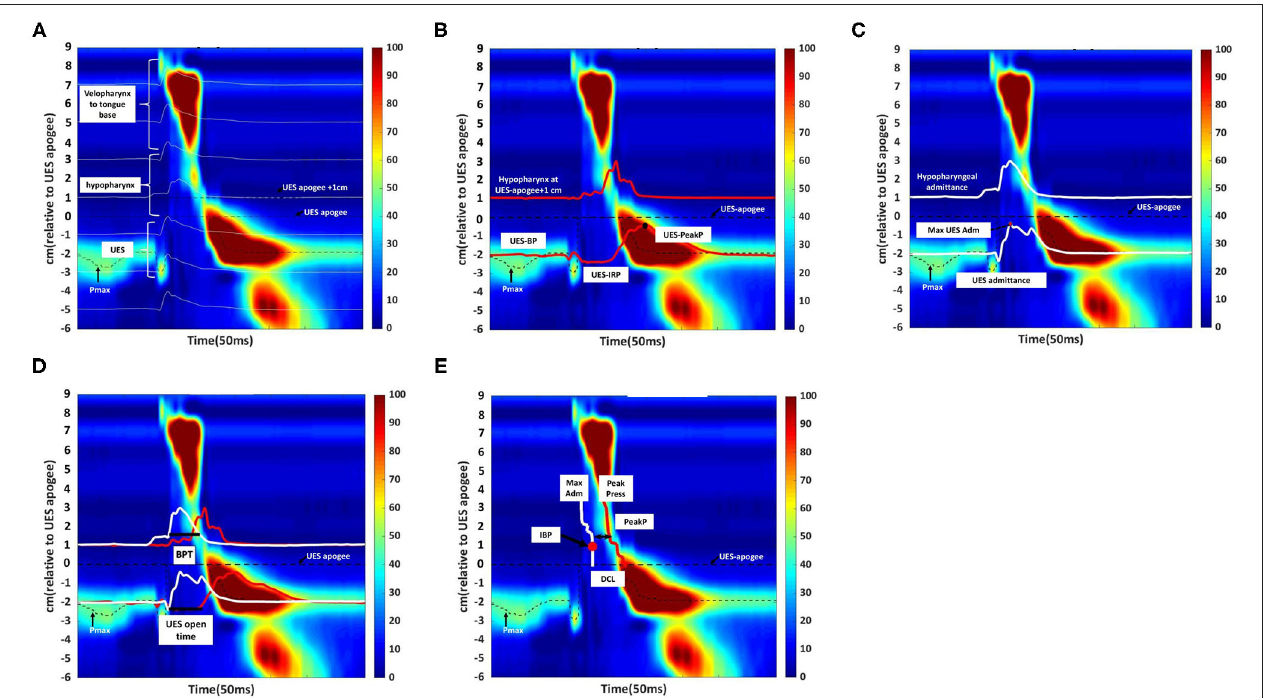
FIGURE 3 | Swallowing function assessment via High -Resolution Impedance Manometry (HRIM). (A) Illustrative example of our data from the pressure sensors on the HRIM catheter (y-axis) over time (x-axis). The graph shows the oropharyngeal pressure topography, from the velopharynx to the tongue base, hypopharynx, and into the upper esophageal sphincter (UES). The high-pressure zone is the UES. The impedance channels from the velopharynx into the esophagus are indicated by white horizontal lines. Effective oropharyngeal muscle contraction relies on bolus transmission, during which the impedance level decreases. (B) Illustrative example of measurement of the parameters of hypopharyngeal and upper esophageal sphincter (UES) pressures. The upper red line represents the pressure waveform recorded at the hypopharynx during the swallow (apogee + 1cm). The lower red line represents the UES pressure waveform, constructed from pressures recorded at the maximum UES pressure position over time. The mean pre-deglutitive UES basal pressure (UES-BP), UES integrated relaxation pressure (UES-IRP), and post-deglutitive UES peak pressure (UES-PeakP) can be identified at the lower red lines. (C) Illustrative example of measurement of the parameters of hypopharyngeal and upper esophageal sphincter admittance. Admittance (S) is the inverse product of impedance ( Ω ), i.e., S = 1/ Ω . Admittance increases with bolus distension of the hypopharynx and UES. The maximum admittance within the UES (Max UES Adm) is represented by the maximum cross-sectional area of the lumen. The lower white line represents the UES admittance waveform, which is constructed from impedance recorded at the Pmax position over the swallowing period. The upper white line represents the admittance waveform at the hypopharyngeal position during the swallow (apogee + 1cm). (D) Illustrative example of measurement of bolus presence time (BPT) and upper esophageal sphincter (UES) open time. The lower section of the graph represents the UES region. The red line represents the UES pressure waveform, which is constructed from pressures recorded at the Pmax position over time. The white line represents the admittance waveform. UES open time was calculated from UES admittance and the pressure waveform, which were used together to define the onset of UES opening (based on the admittance upstroke in the UES), and UES closure (based on the pressure upstroke in the UES). The upper section of the graph represents the hypopharynx region (apogee + 1cm). The red line represents the hypopharyngeal pressure waveform, and the white line represents the admittance waveform. The UES admittance level at the time of closure was used as the threshold to commence the hypopharyngeal admittance recording. The period when hypopharyngeal admittance exceeded this threshold was defined as the bolus presence time (BPT). (E) Illustrative example of measurement of the hypopharyngeal parameters. The white line indicates the maximum admittance (Max Adm) in the hypopharynx region. The red line indicates the mean value of the hypopharyngeal peak pressure (Mean Peak) in the hypopharynx region. Distension-contraction latency (DCL) reflects the time of maximum bolus distension and maximum contraction of the hypopharynx during the swallow. Hypopharyngeal intrabolus distension pressure (IBP) is defined as the pressure at maximum distension (at the position of Max Adm), 1cm proximal to the UES apogee. The upper esophageal sphincter (UES) apogee is defined by visualization of the orad movement of the UES high-pressure zone to determine the highest position of the proximal edge of the high-pressure zone during swallowing. The Pmax position is defined as the position at the maximum pressure of